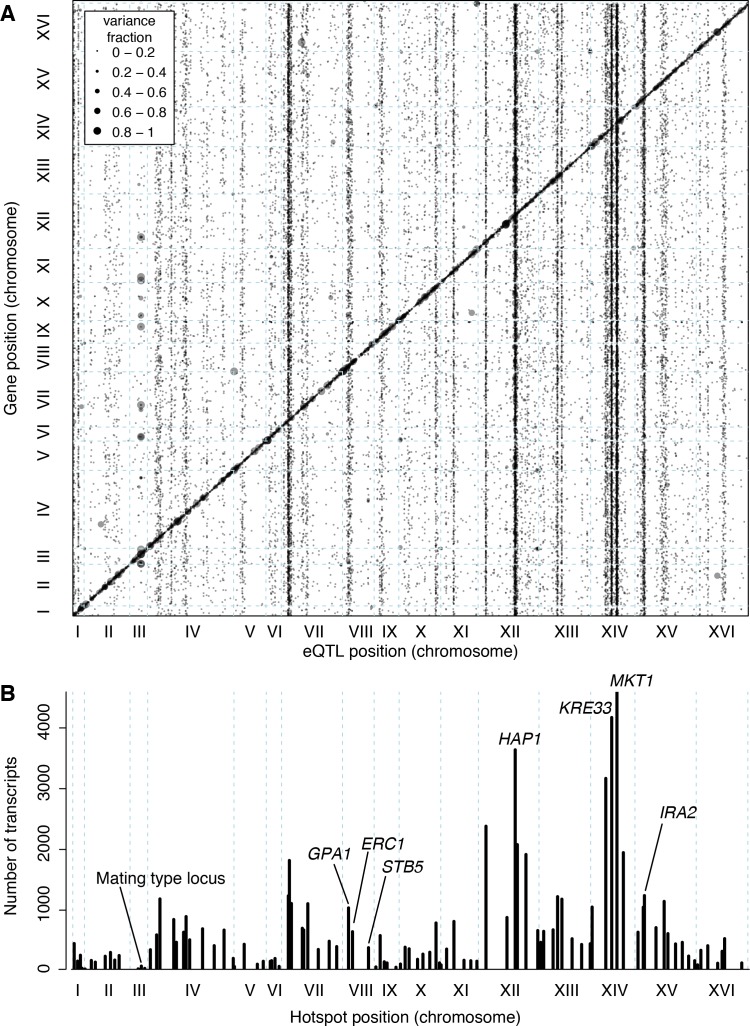
Locations of eQTLs in the genome.(A) Map of local and distant eQTLs. The genomic locations of eQTL peaks (x-axis) are plotted against the genomic locations of the genes whose expression they influence (y-axis). The strong diagonal band corresponds to local eQTLs. The many vertical bands correspond to eQTL hotspots. Point size is scaled as a function of eQTL effect size, measured in fraction of phenotypic variance explained. (B) The number of gene expression traits linking to each of 102 identified eQTL hotspots (Methods) are shown as vertical bars. Text labels identify genes in hotspots referred to in the text.